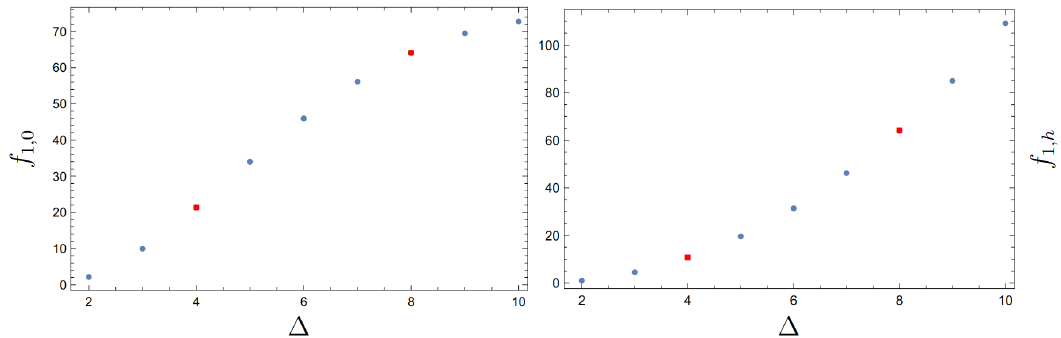
Figure 13 . Normalizable coefficients, (A.13) and (A.14), of the bulk scalar field dual to the conformal order parameter O in the limit b → + ∞ . The red squares represent the analytical ∆ results obtained for ∆ = 4 and ∆ = 8